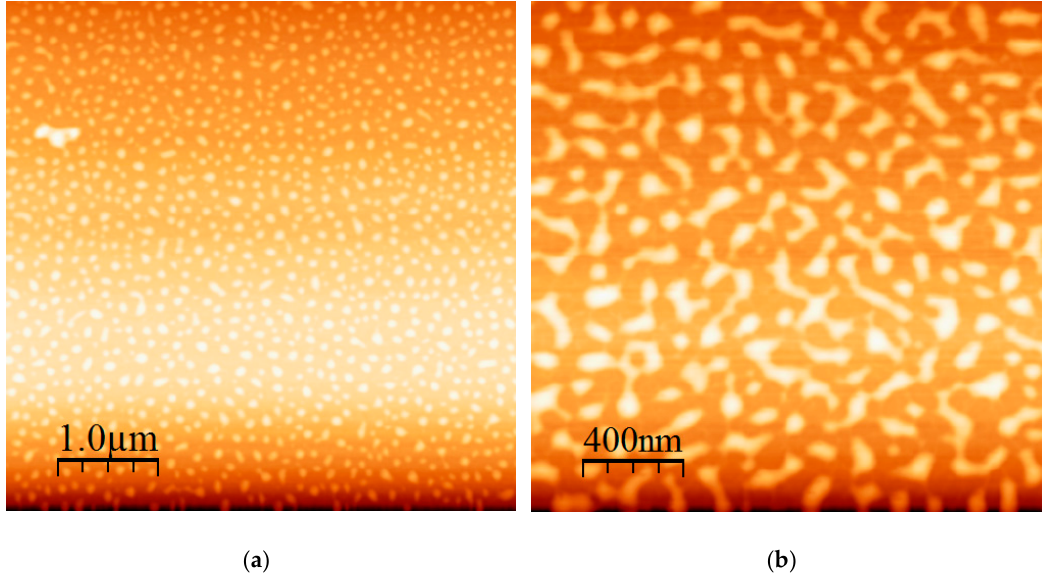
Figure 10. ( a ) AFM height image of HIH, c = 4 × 10 − 4 g / mL, and ( b ) AFM height image of HIH, c = 1 × 10 − 3 g /